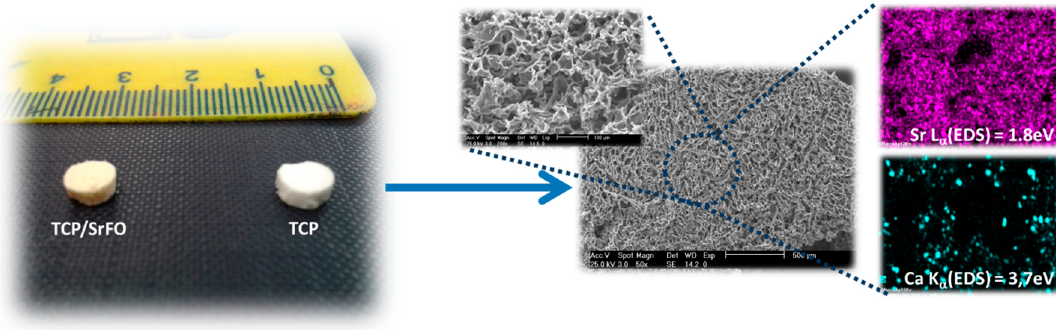
Figure 6. β -tricalcium phosphate (TCP) and TCP/SrFO porous scaffolds obtained by free radical polymerization and lyophilization and surface analysis by scanning electron microscope (SEM) and energy-dispersive X-ray spectroscopy (EDS) spectroscopy [107].